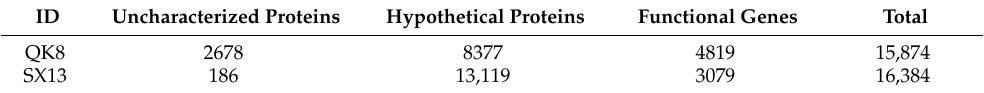
Table 3. Results of the gene function annotation results of strains QK8 and